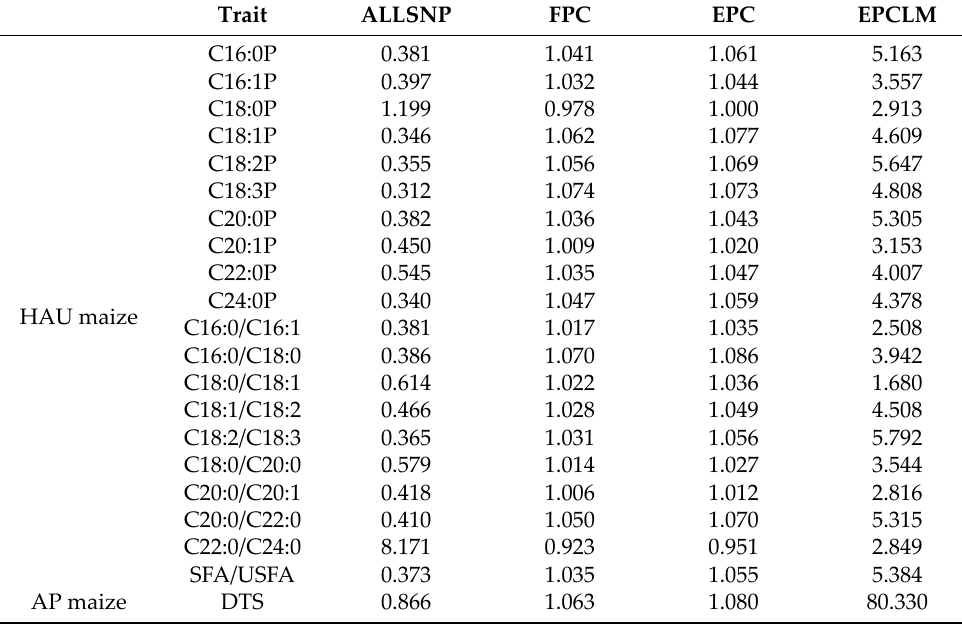
Table 1. GC value of different methods for HAU maize and AP maize traits. Trait ALLSNP FPC EPC EPCLM C16:0P